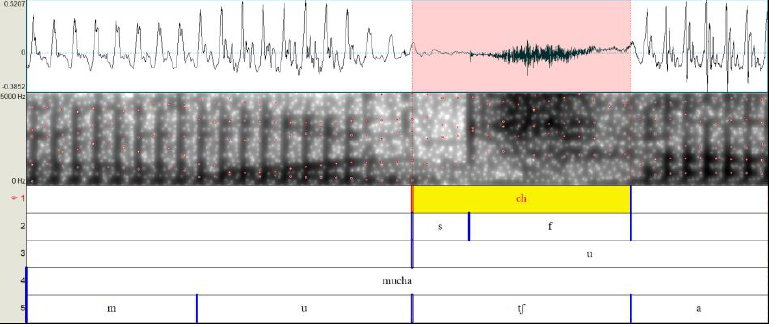
Figure 1. Transcription of the interview in PraatAlign. Male speaker (UT008).